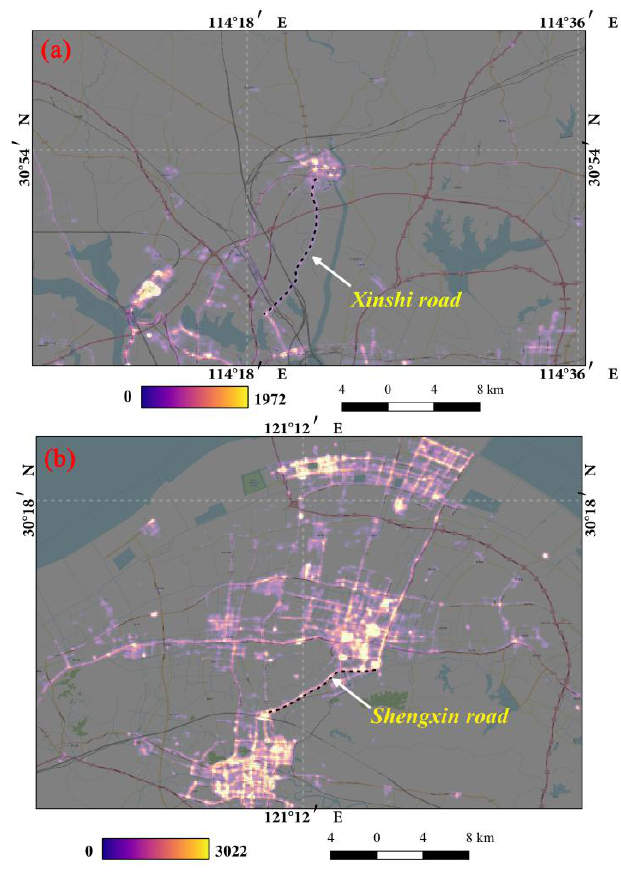
Figure 8. The artificial nighttime light along roads: ( a ) refers to the Xinshi road in Wuhan; ( b ) refers to the Shengxin road in Ningbo. ( a ) and ( b ) are the LuoJia1-01 nighttime light images overlaid on Google Earth high-resolution images with 50% transparency.